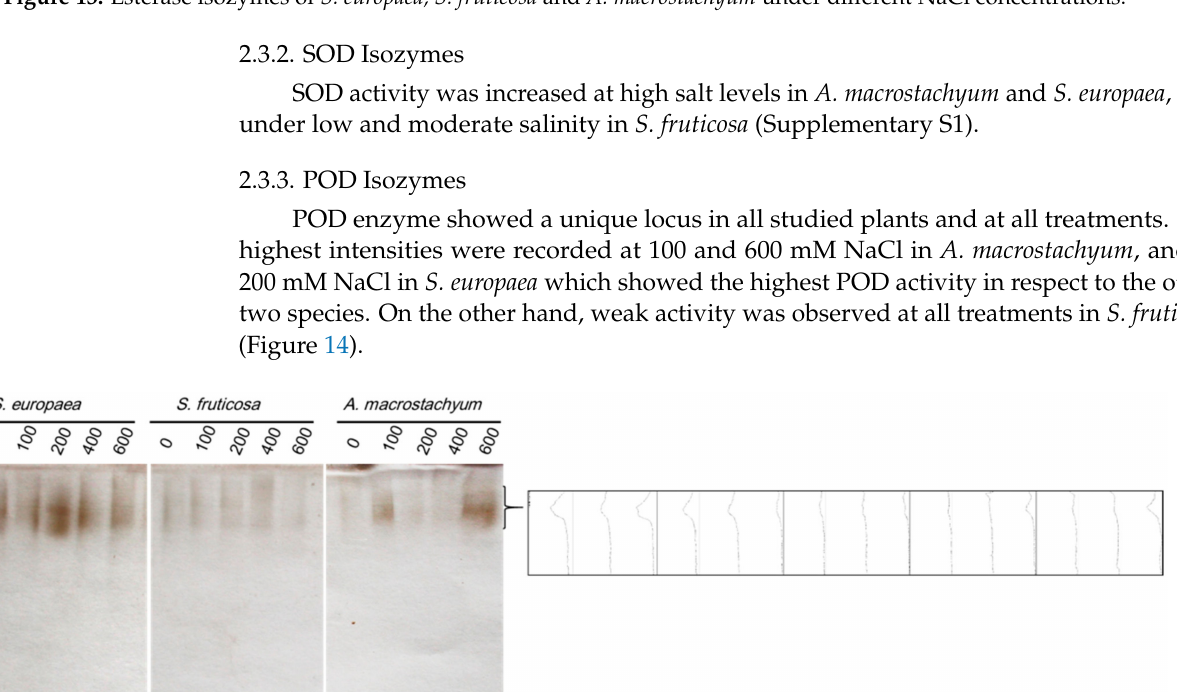
Figure 13. Esterase isozymes of S. europaea, S. fruticosa and A. macrostachyum under different NaCl concentrations.